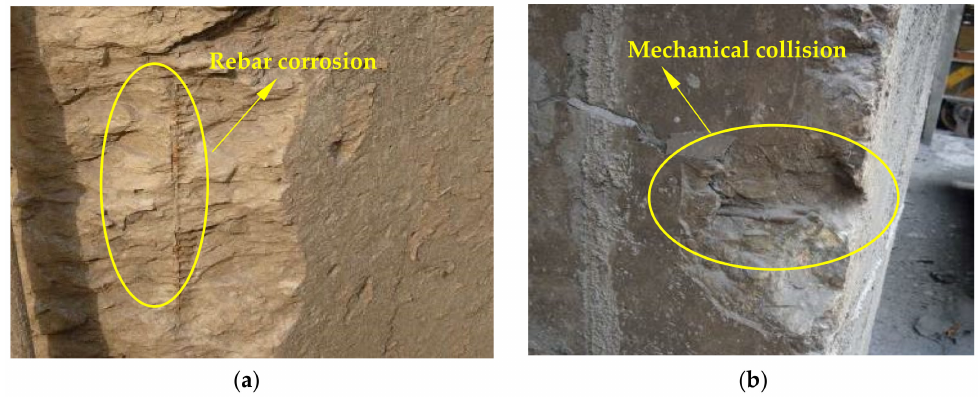
Figure 5. The appearance of concrete structures in the steelworks: ( a ) Ingot casting bay; ( b ) Billet